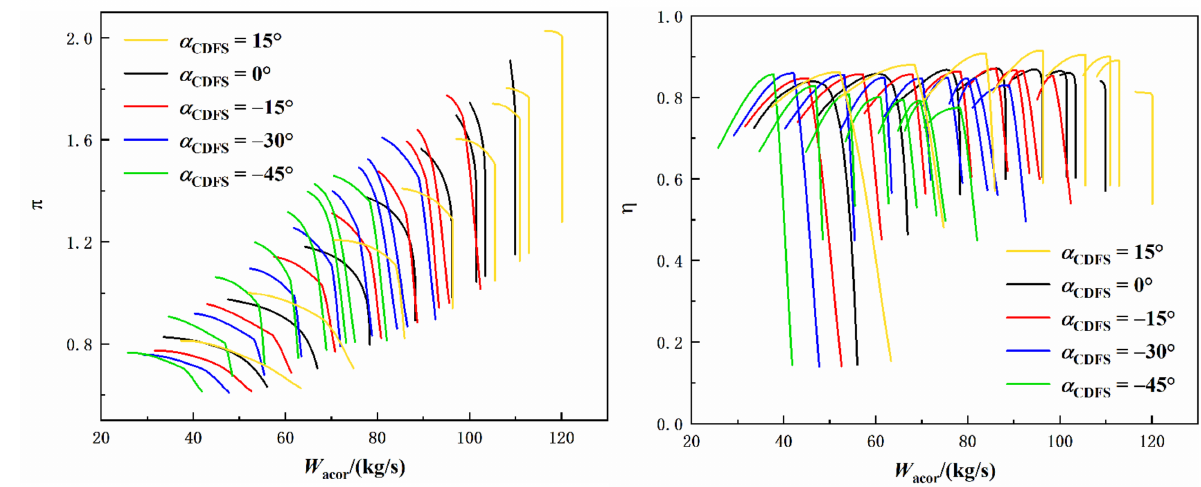
Figure 10. Characteristic maps of the D CDFS .